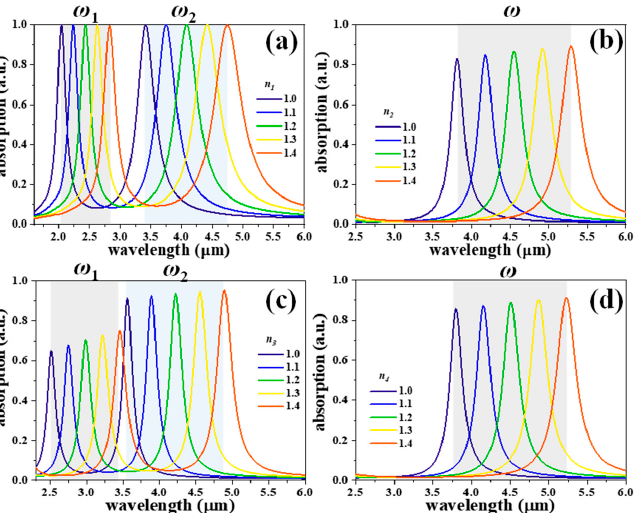
Figure 5. Absorption spectra of ( a ) SDM-1, ( b ) SDM-2, ( c ) SDM-3, and ( d ) SDM-4 exposed to ambient environments with different refraction indexes, where z , a , and b values are kept constant as z = 50 nm, a = 300 nm, and b = 200 nm, respectively.